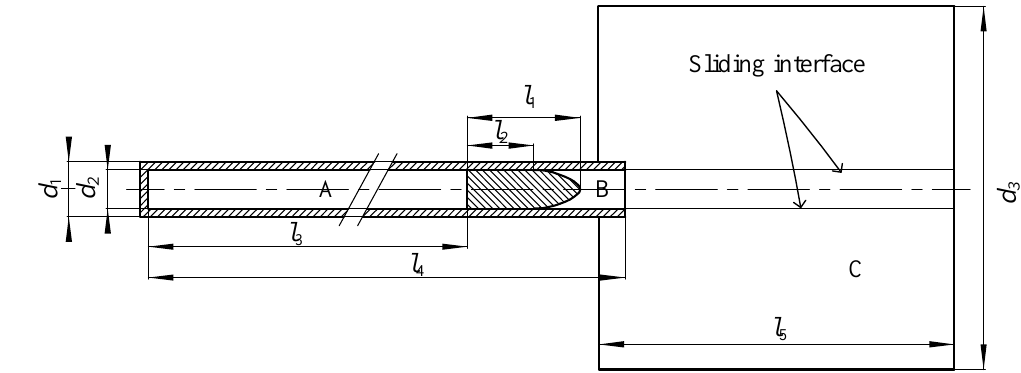
Fig.2 Computation domain Figure 1. Computation domain model. Figure 1. Computation domain Table 1. Specification of 125 mm gun.